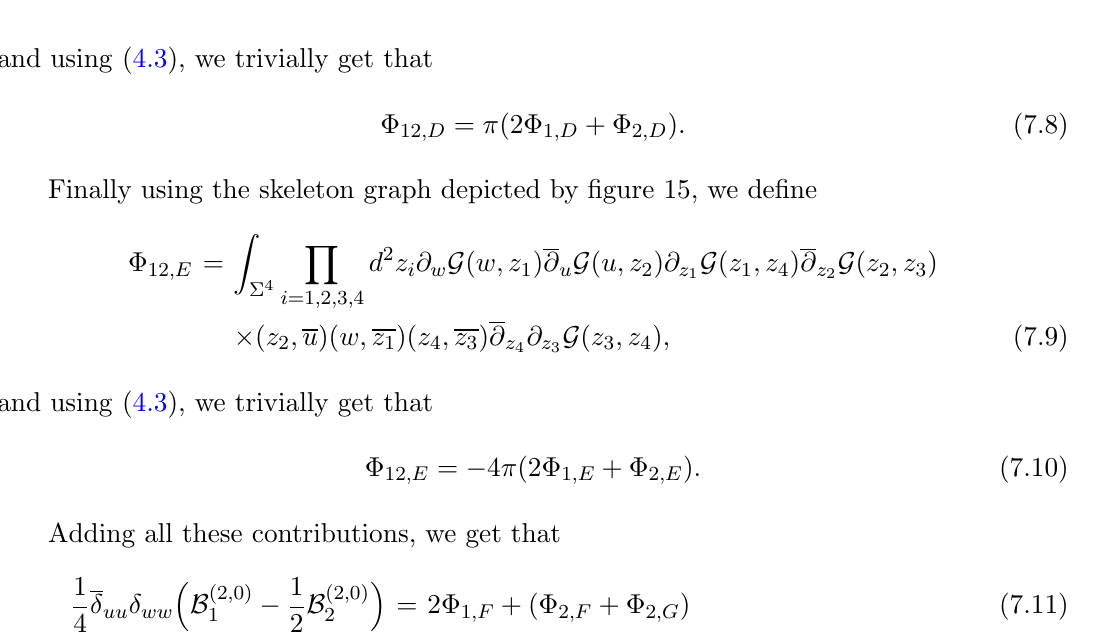
Figure 15 . Skeleton graph for (cid:8) 12 ;E